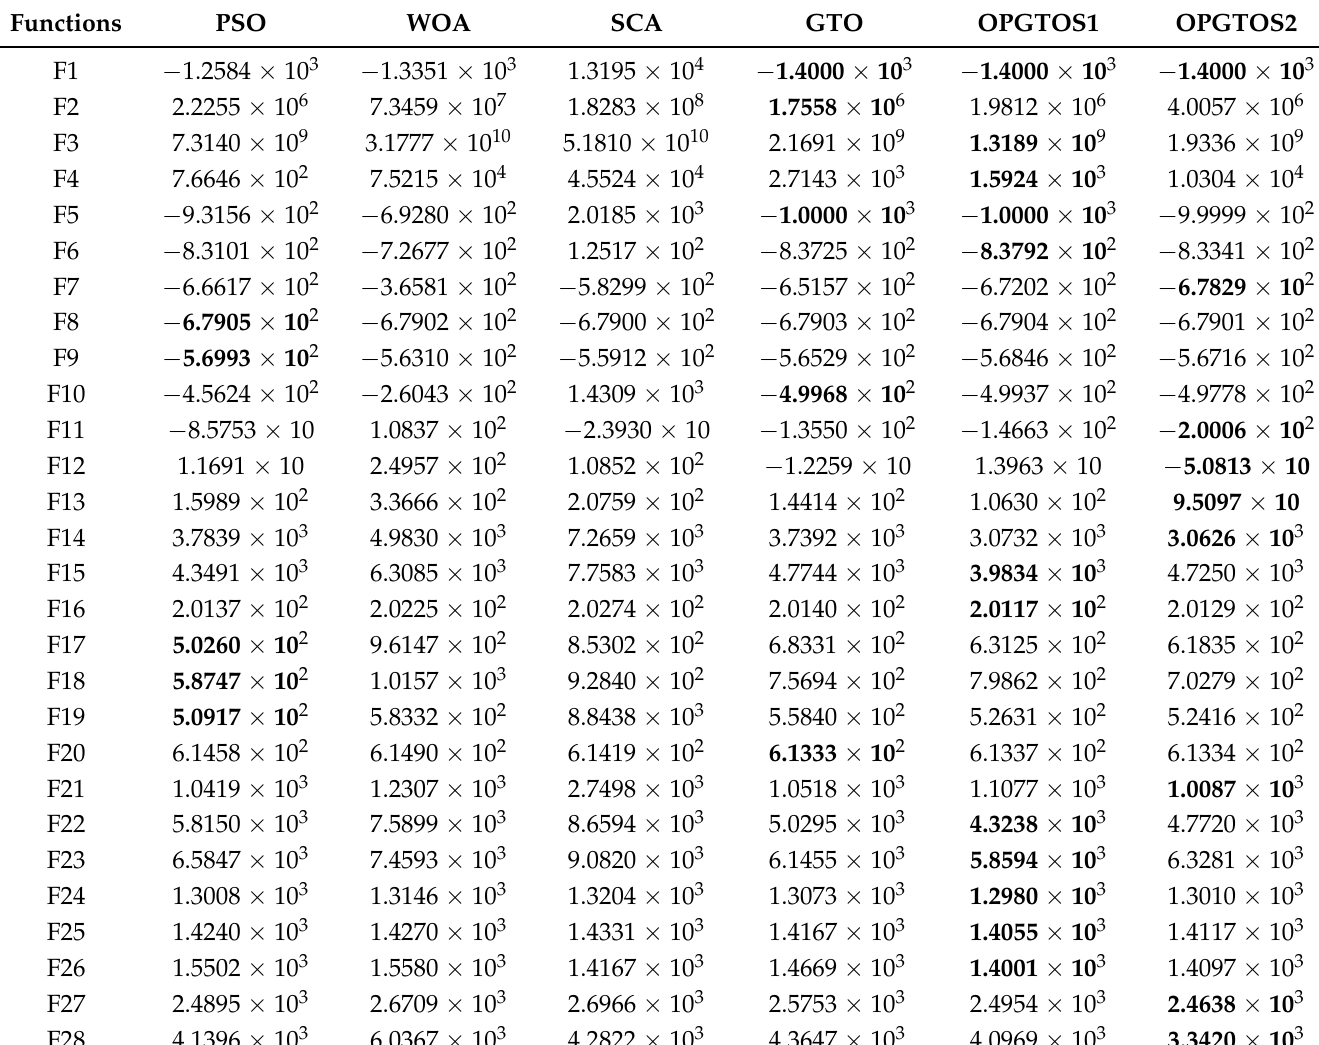
Table 3. Simulation results of CEC2013 functions in 30